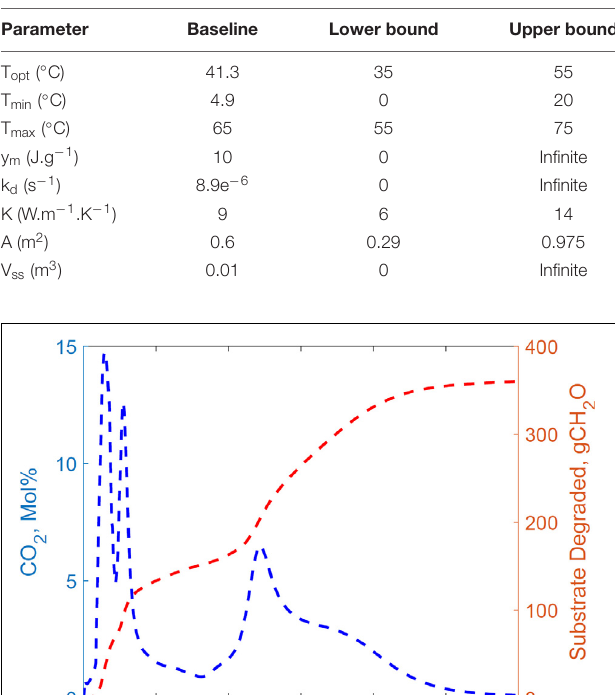
TABLE 2 | Parameters, baseline, and bounds for the system dynamics model calibration.